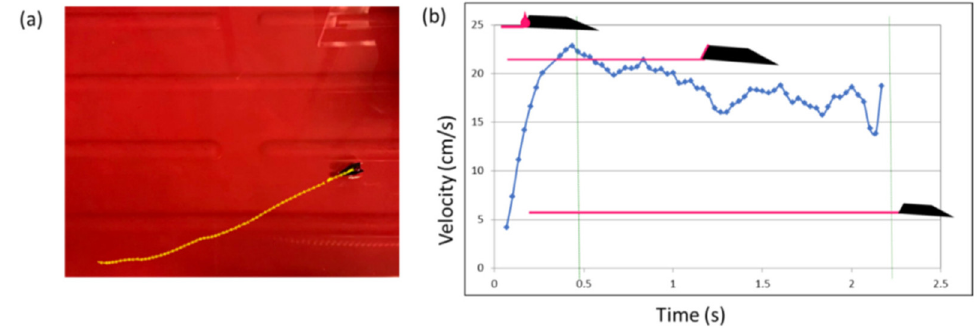
Figure 8. ( a , b ) When the boat was free to move over a bigger surface, we observed the propulsion from one side to the opposite.